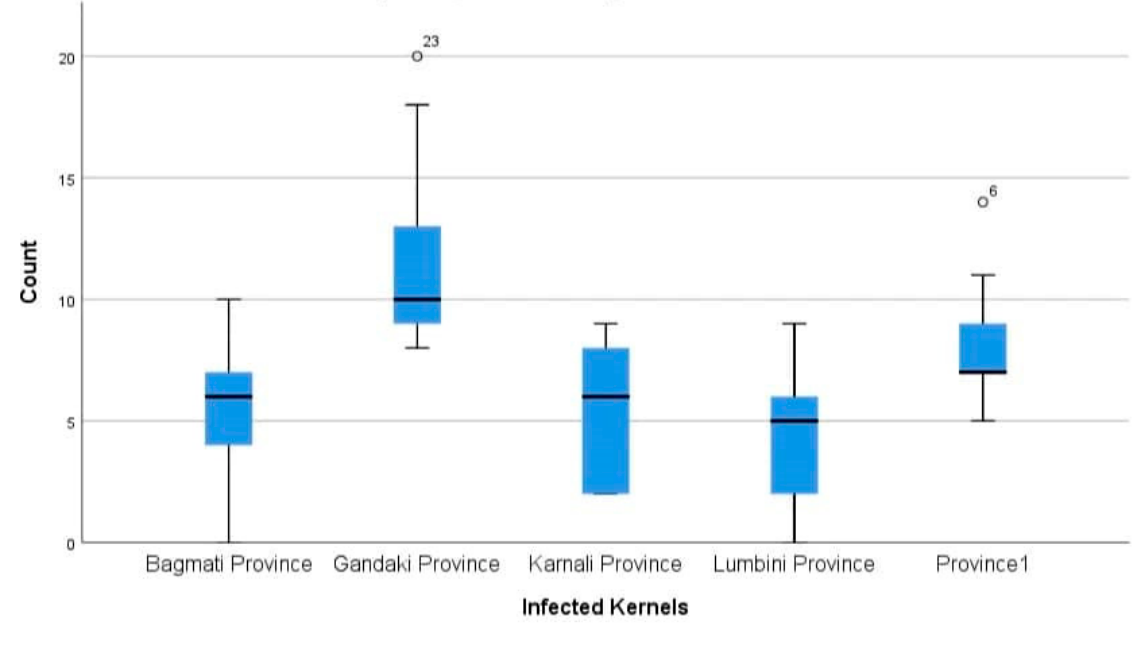
Figure A6. Infected maize kernels in five different provinces of Nepal.